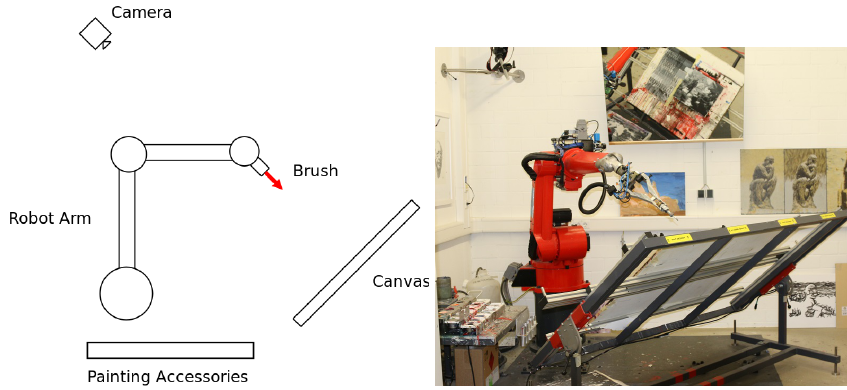
Figure 11. Schematic ( Left ) and actual ( Right ) layout of e-David.